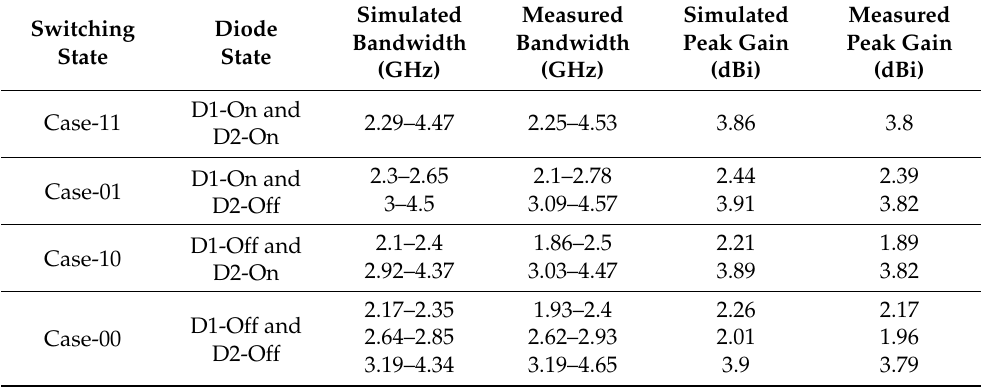
Figure 11. Simulated and measured gain along with radiation efficiency: ( a ) case-11 ( b ) case-01 ( c ) case-10 ( d ) case-00. Table 2. Comparison among simulated and measured values for various switching states.